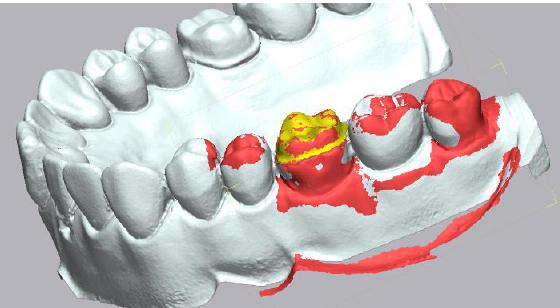
Figure 3. Alignment of the IOS mesh over the reference mesh. The isolated area of interest is displayed in yellow color.